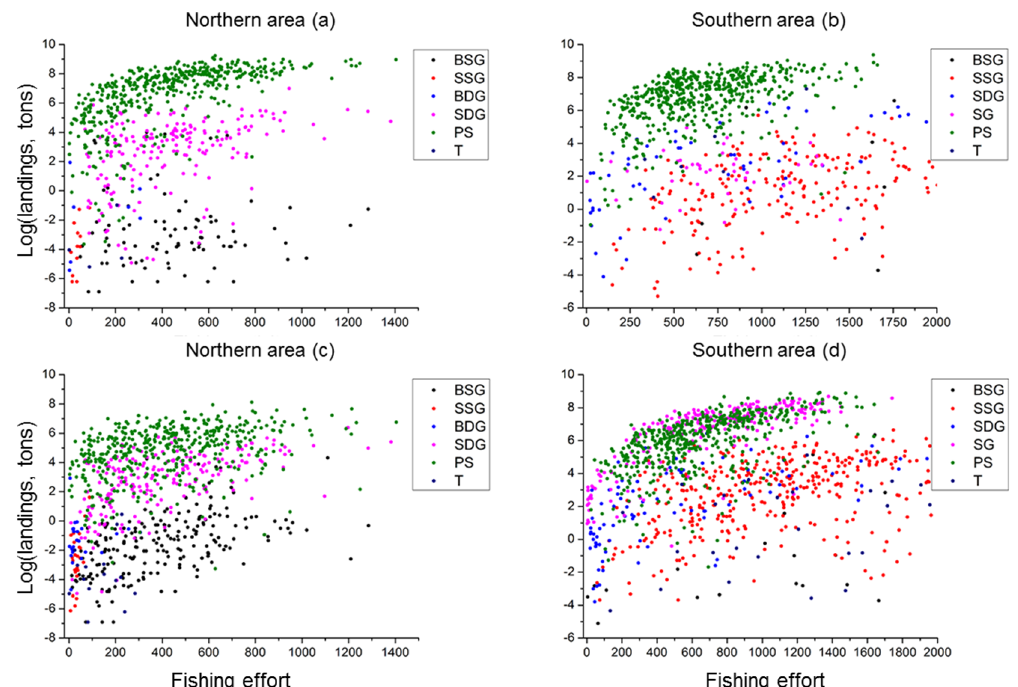
Fig. 3. Relationship between monthly landings of Sardinella aurita (a, b) and Sardinella maderensis (c, d) and fi shing effort (number of trips) by fi shing gear in the northern and southern area in Senegalese waters (2004 –